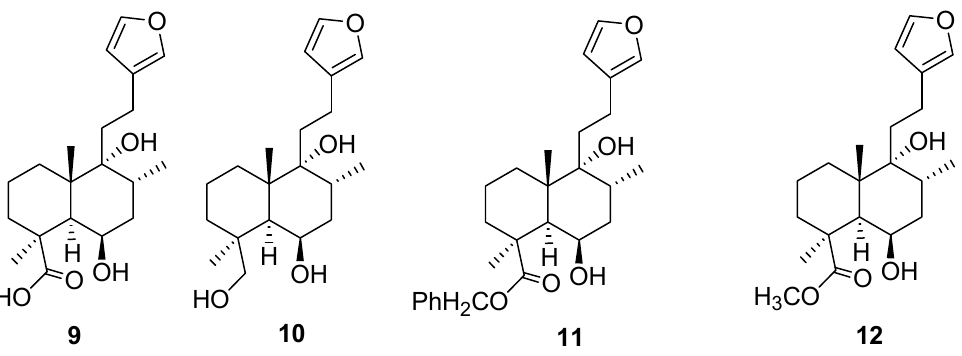
Figure 3. Different derivatives of marrubiin (compounds 9 – 12 ).